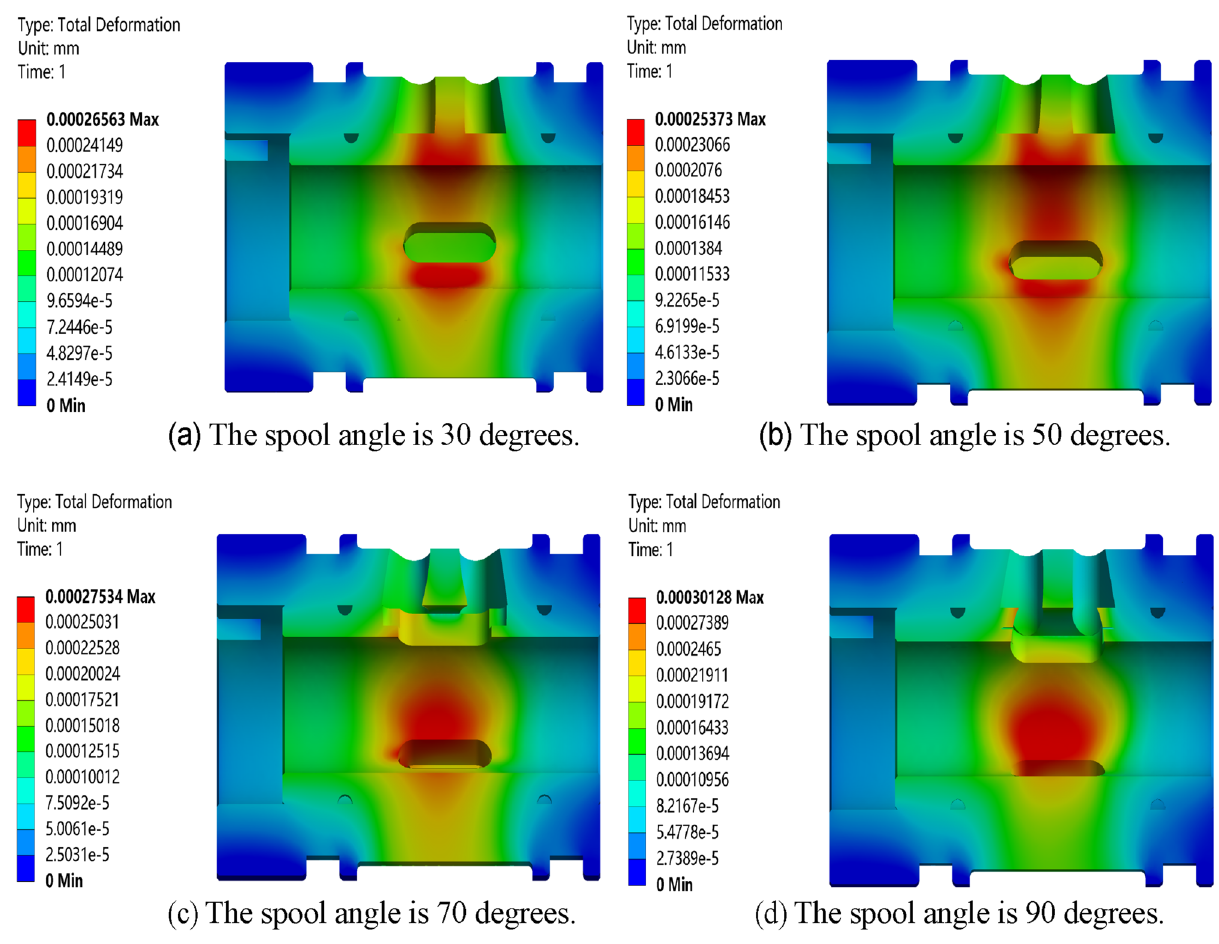
Figure 19. Deformation diagram of valve sleeve and valve core under U-shaped buffer